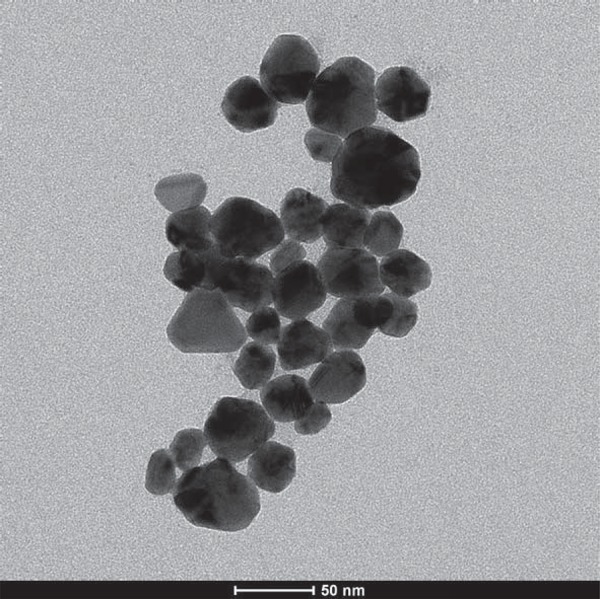
Particle size distribution for the AgNPs